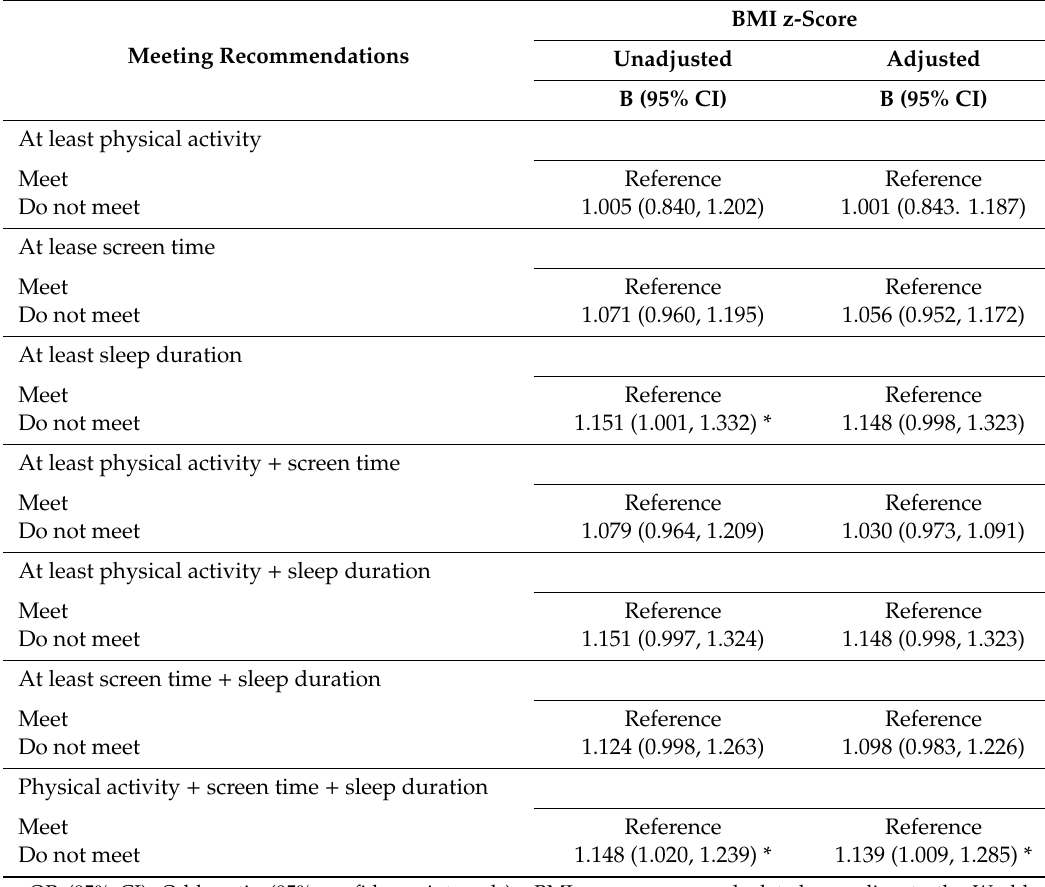
Table 2. Associations between meeting the combinations of the 24-Hour Movement Guidelines and adiposity among young children ( n =